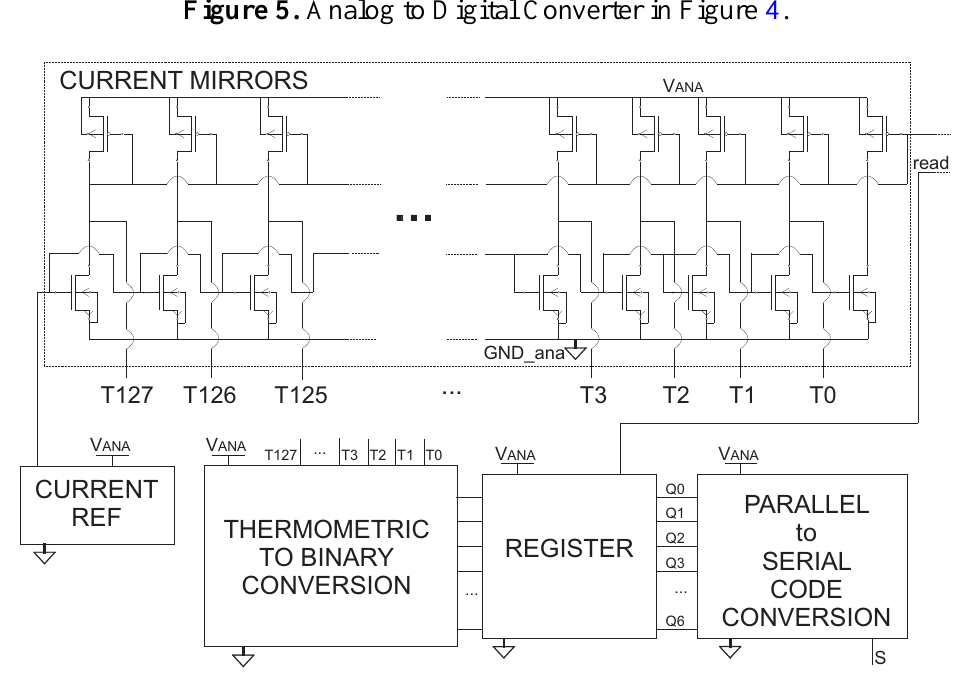
Figure 5. Analog to Digital Converter in Figure